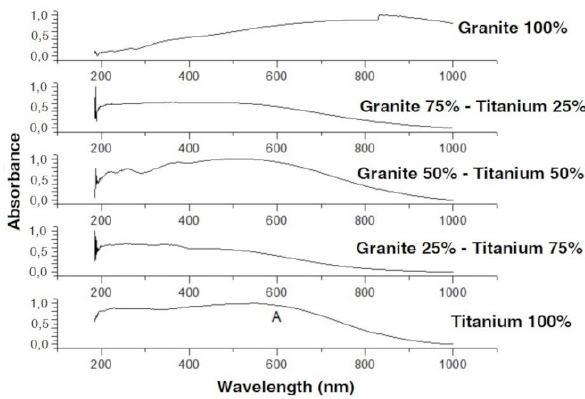
Figure 4: Absorbance graphs of selective surfaces produced.